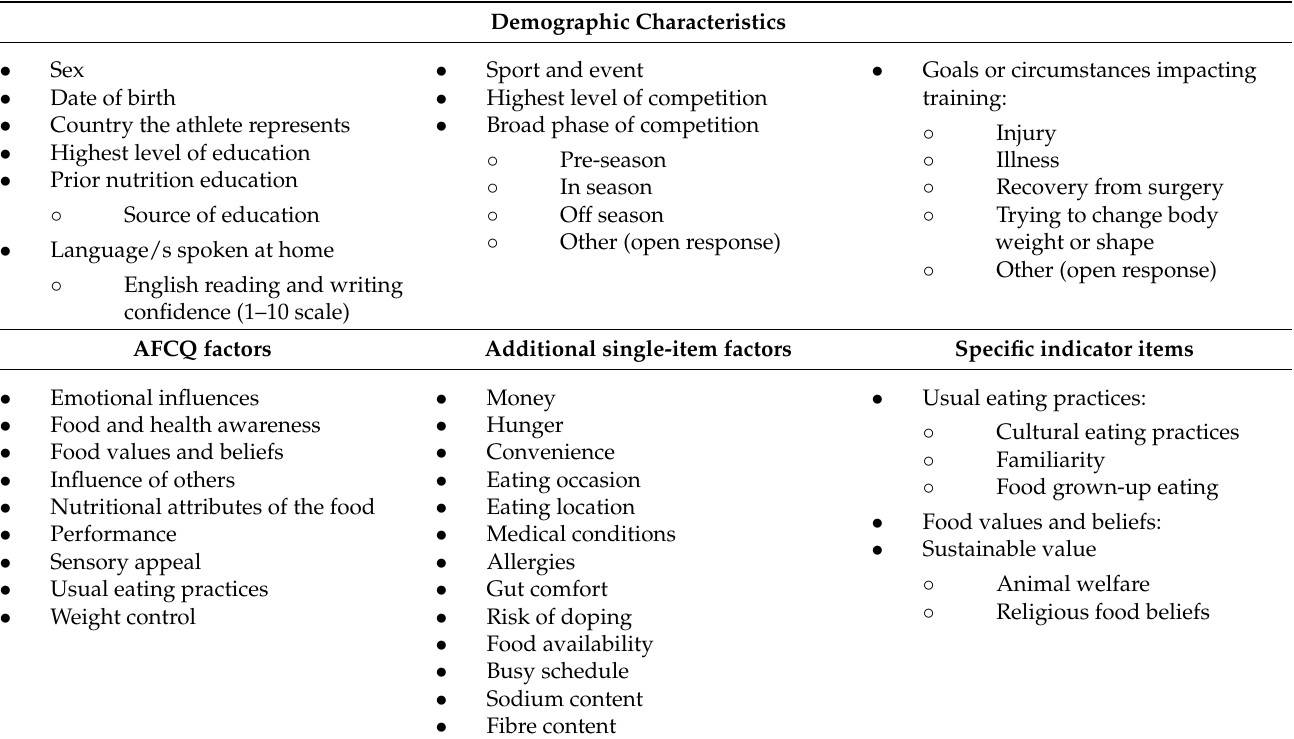
Table 1. Summary of data collection